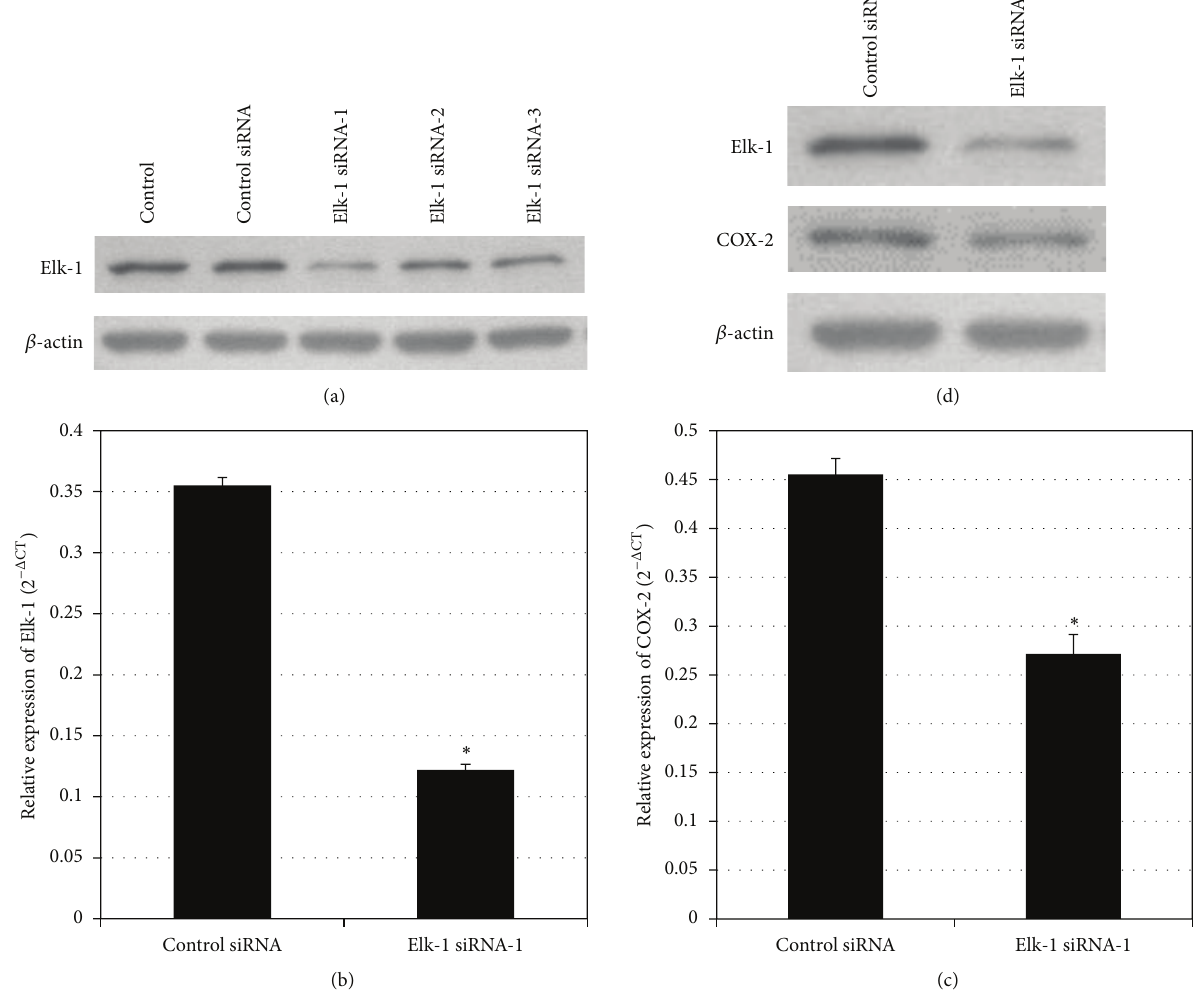
Figure2:Elk-1RNAidownregulatedCOX-2geneexpression.(a)INS-1cellsweretransientlytransfectedwithcontrolsiRNAandElk-1siRNAs (1, 2, and 3), respectively. Untransfected cells were used as control. 48 h after transfection, Elk-1 protein levels were assayed by Western blot analysis. 𝛽 -actin levels served as internal control. (b and c) INS-1 cells were transiently transfected with control siRNA and Elk-1 siRNA- 1, respectively. 48 h after transfection, Elk-1 and COX-2 mRNA levels were determined by quantitative real-time RT-PCR. Relative mRNA expression was expressed as mean ± SEM. ∗ 𝑃 < 0.001 versus control siRNA transfected group. (d) Elk-1 and COX-2 protein levels were assayed by Western blot analysis. 𝛽 -actin levels served as internal